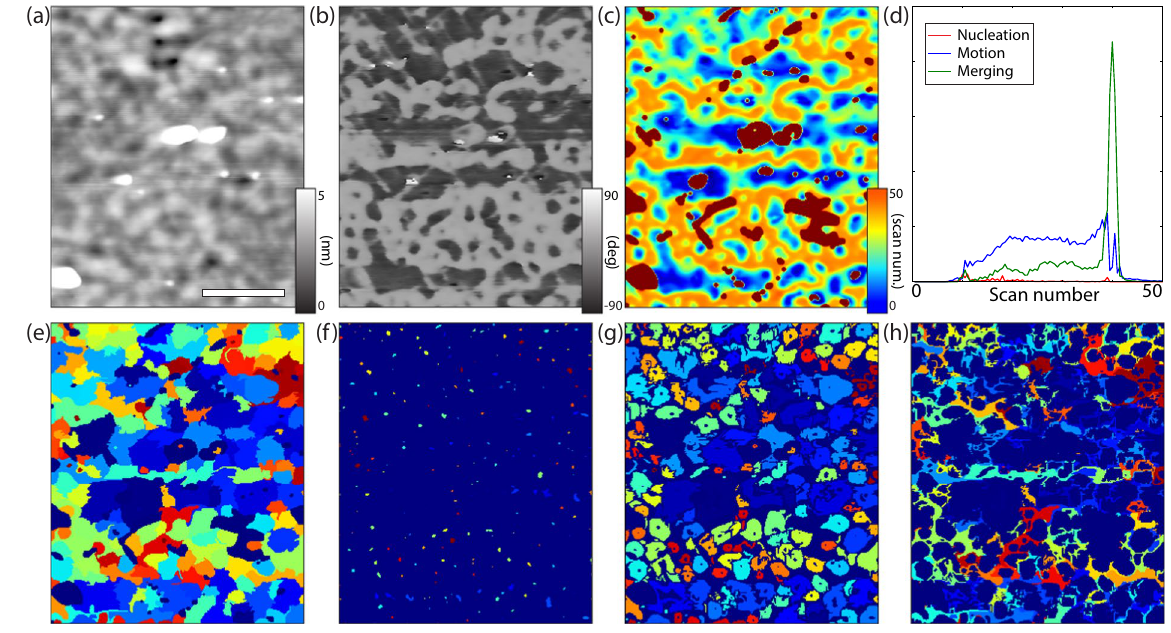
Figure 3. Investigations of the domain structure of a PZT thin film whose topography is shown in ( a ). The domain structure at a given time point ( b ) is noisy, so an in-depth analysis is used to extract the time-of- switching map ( c ). The map can be analysed and broken down into domain nucleation (red), motion (blue), and merging (green) events whose time distribution is shown in ( d ). Each domain can then be individually tracked from its nucleation onward, illustrated in one colour per domain in ( e ). The domain nucleation, motion and merging regions are shown in ( f – h ) respectively, opening the pathway to an analysis of the defect landscape and domain avalanche